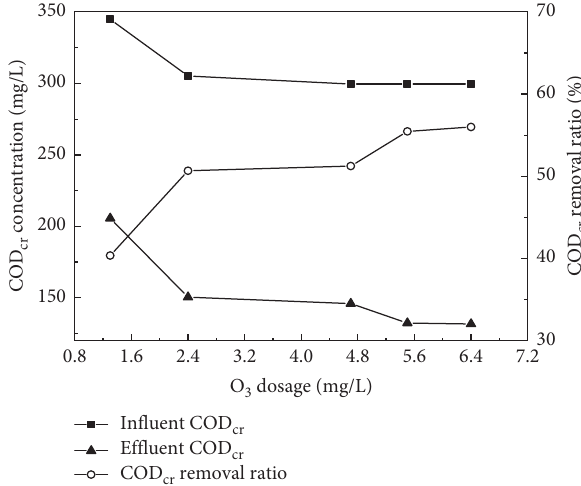
Figure 6: Effect of O